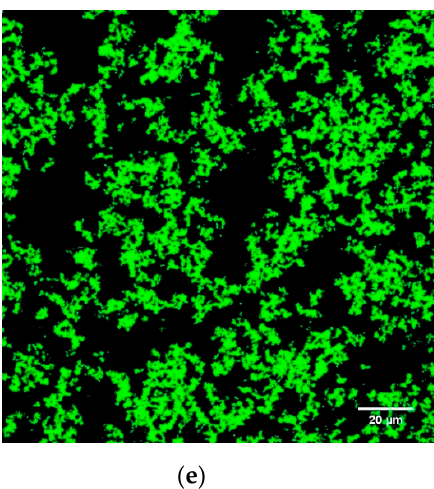
Figure 4. CLSM (confocal laser scanning microscopy) images of plain ADG 0% ( a ), ADG with 15% black tea infusion ( b ), ADG with 30% black tea infusion ( c ), ADG with 45% black tea infusion ( d ), ADG with 60% black tea infusion ( e ) (day 1). Protein stained by Fast Green FCF appears as green and non-fluorescent areas (dark areas) correspond to the serum pores.